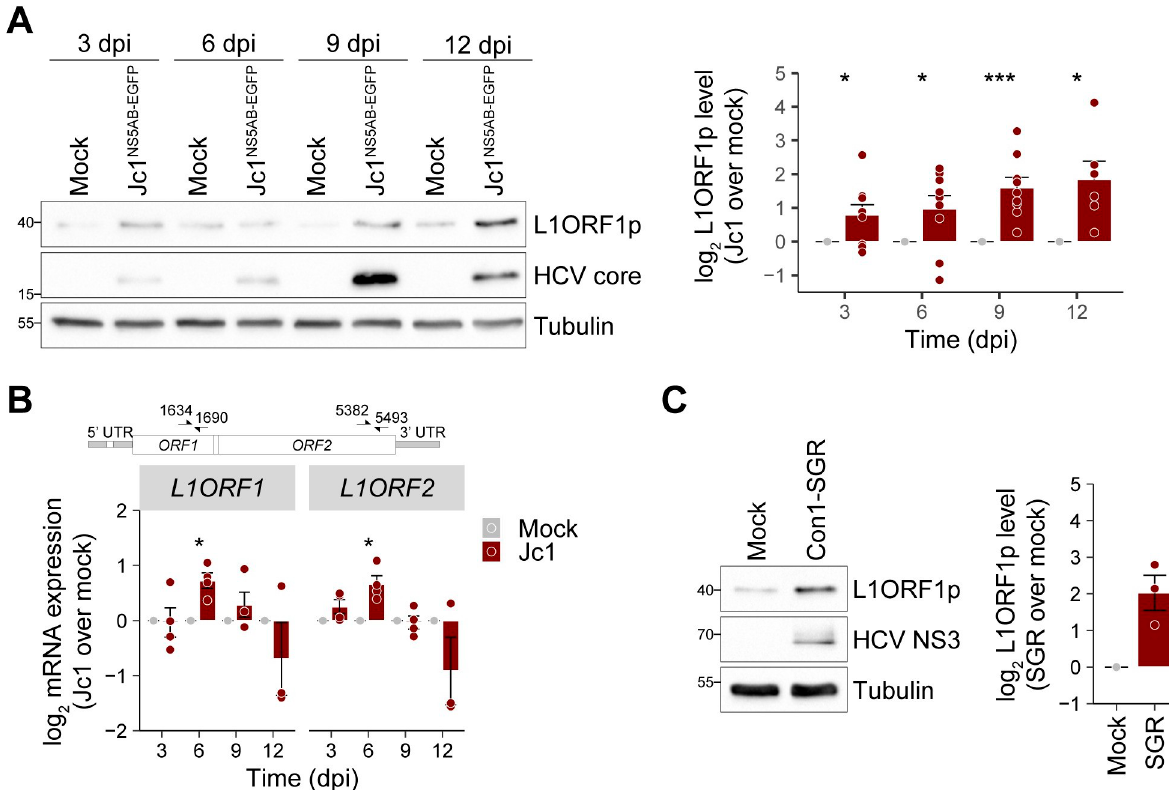
Fig 2. HCV infection increases L1ORF1p protein levels. (A) L1ORF1p protein levels in mock and Jc1 NS5AB-EGFP -infected Huh7.5 cells (MOI 0.2) were analyzed by immunoblotting at 3–12 dpi and quantified by densitometry. Shown is the relative L1ORF1p level normalized to tubulin expression (mean ± SEM, n = 6–9, � p < 0.05, ��� p < 0.001, Welch’s t-test) that demonstrates a strong increase of L1ORF1p expression in HCV- infected cells. (B) HCV infection transiently increases expression of endogenous full-length L1 elements. Time course of L1 expression after infection of Huh7.5 cells with Jc1 NS5AB-EGFP (MOI 0.2). Endogenous L1 mRNA levels were determined by qRT-PCR using RNA isolated at the indicated time points and primer pairs binding within ORF1 or ORF2 (mean ± SEM, n = 3–4, � p < 0.05, Welch’s t -test). Primer binding sites within L1 sequences are marked in the scheme. (C) L1ORF1p levels in stable polyclonal Huh7.5-Con1-SGR cells were analyzed by immunoblotting and quantified. Shown is the relative L1ORF1p level normalized to tubulin (mean ± SEM, n = 3).